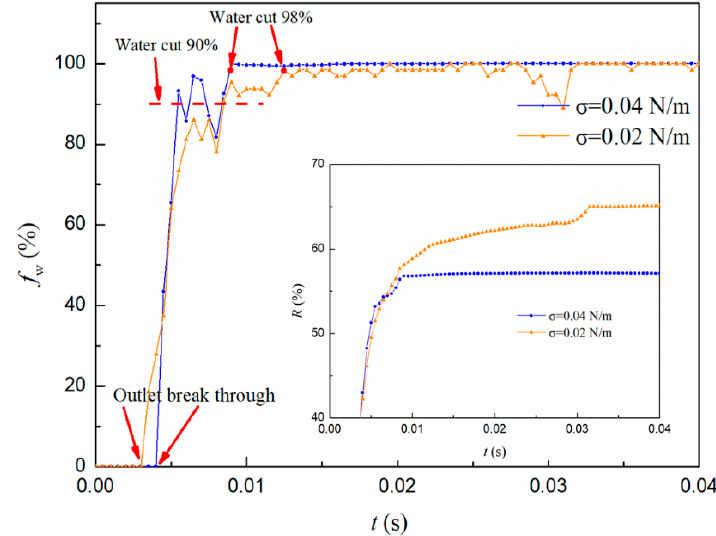
Figure 8. Water cut at the outlet and oil recovery at different interfacial tensions (Y-axis is water cut, % and X-axis is time, s).